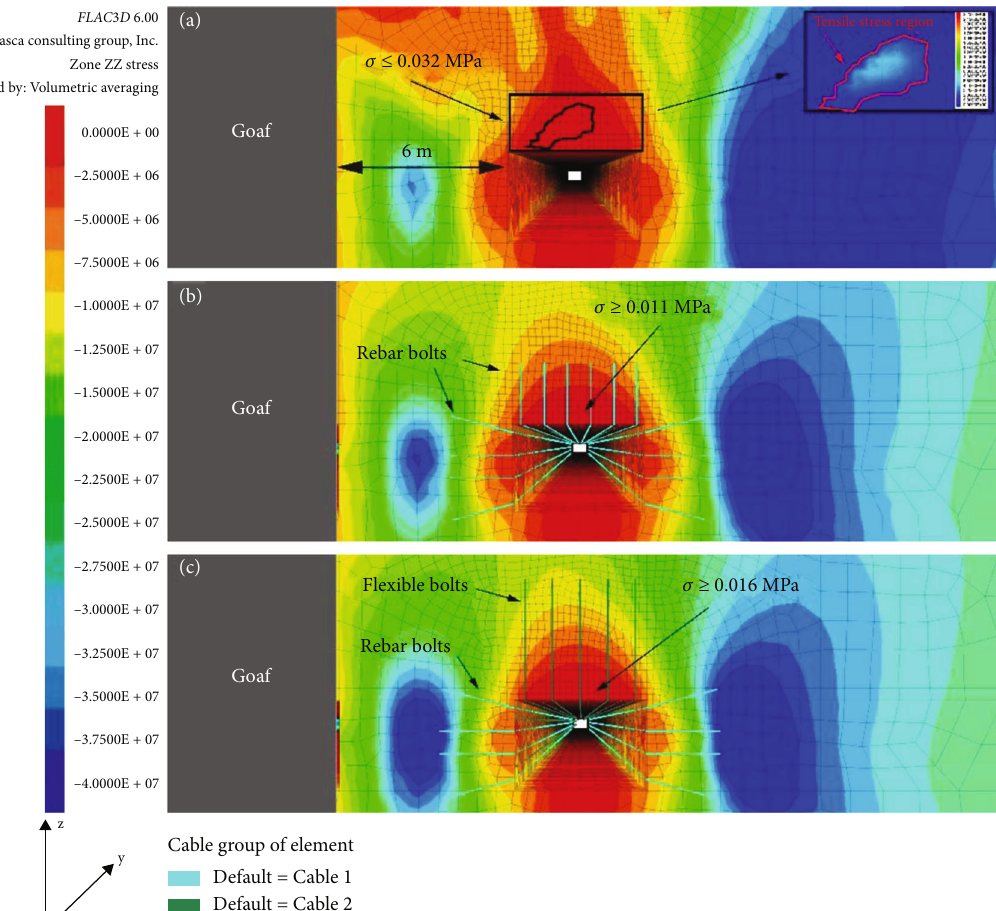
Figure 10: Comparison of vertical stress of roadway under (a) unsupported, (b) original support scheme, and (c) TADL support